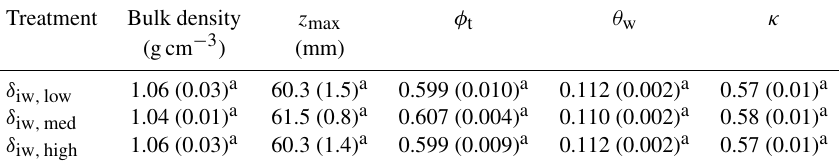
Table 1. Soil properties by irrigation water treatment ( δ iw ). Means ( n = 6) and standard deviations (in parentheses) for bulk density, soil depth ( z max ), total porosity ( φ t ), volumetric soil water content ( θ w ) and tortuosity ( κ ). Superscript letters following each mean and deviation indicate significant differences (one-way analysis of variance and Tukey’s HSD, p < 0 . 01) among δ iw